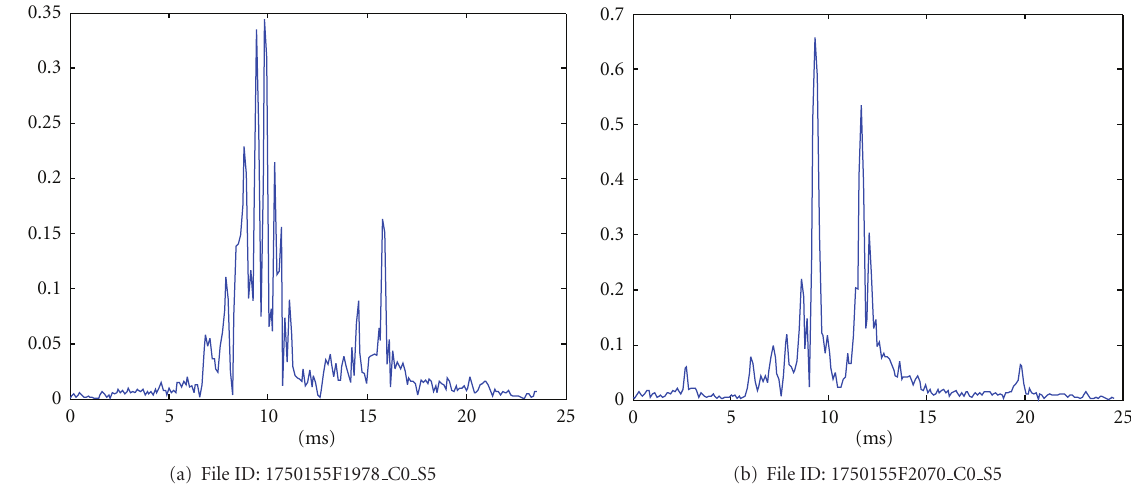
Figure 9: Estimated channel impulse responses for two di ff erent blocks at di ff erent bursts.